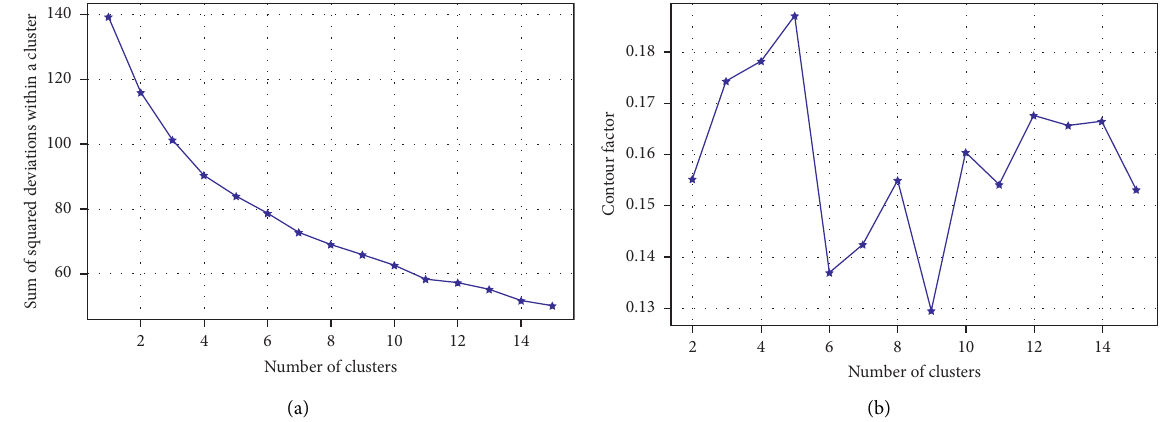
Figure 3: The results of the elbow diagram method (a) and the contour coefficient method (b).